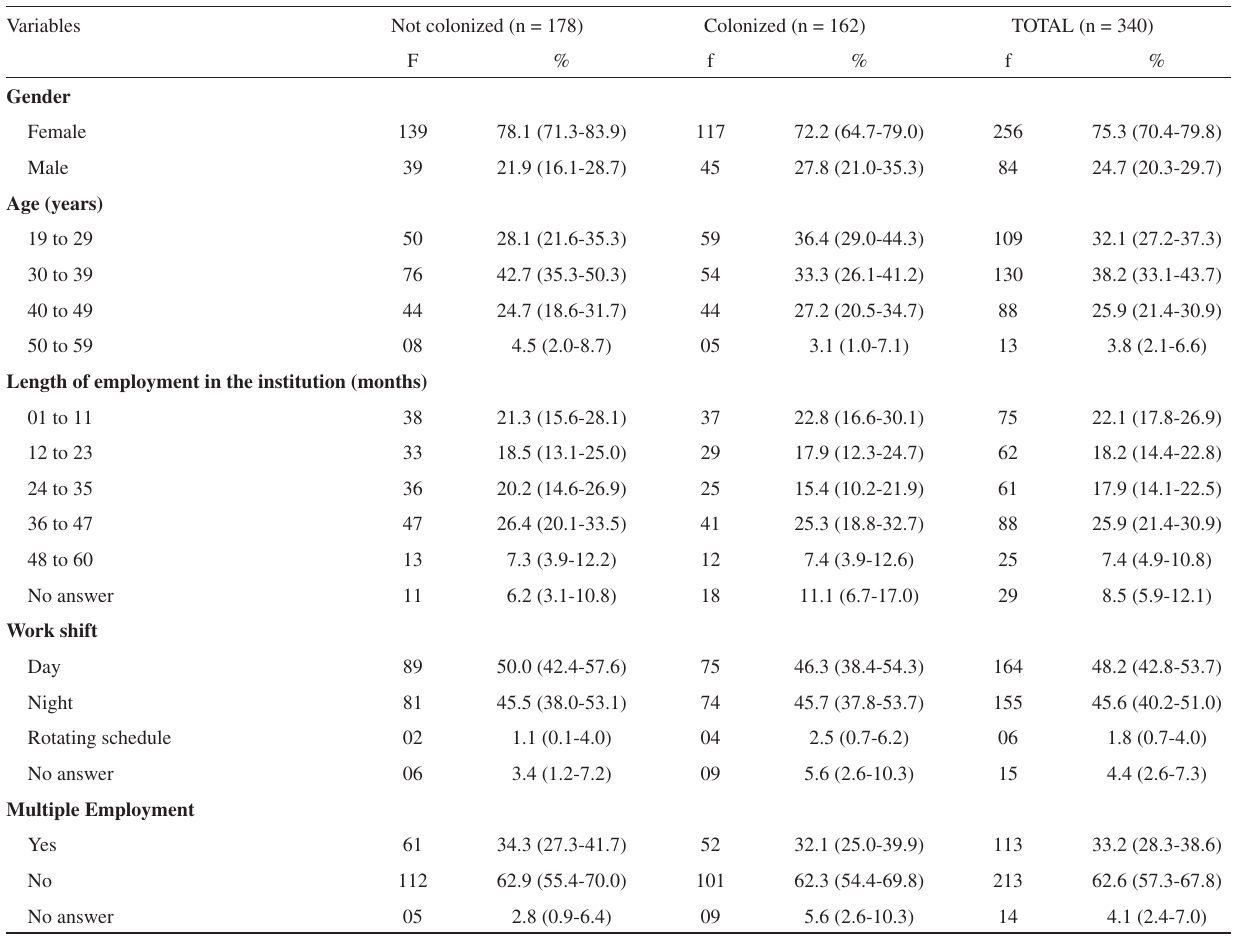
Table 3 - Distribution of participants according to professional and personal characterization and colonization by S. aureus,